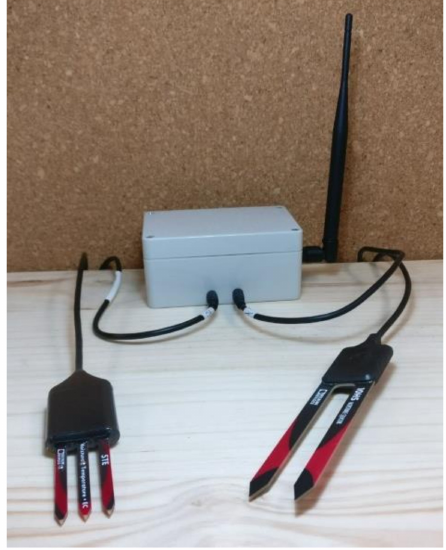
Figure 4. Node with ECH2O soil moisture sensors.